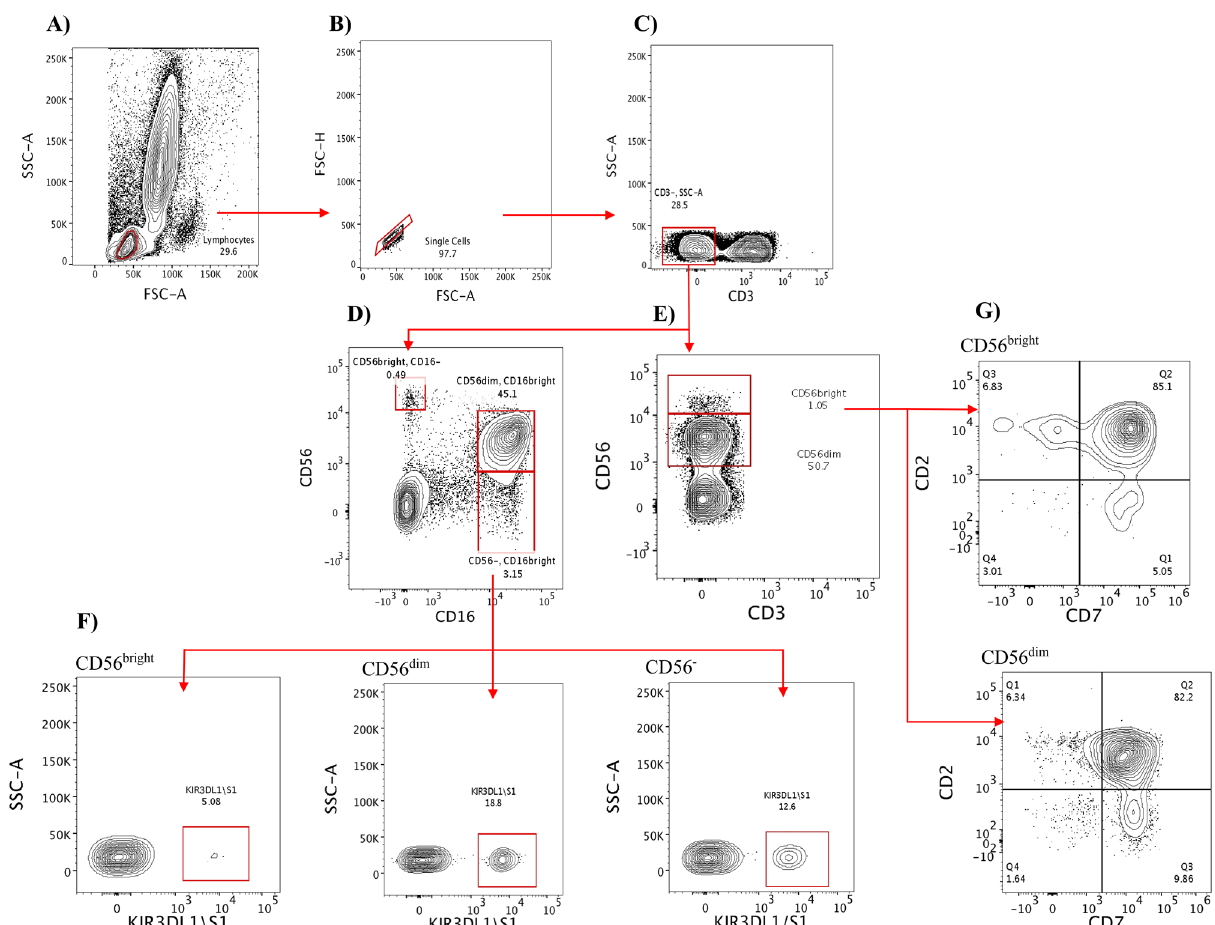
Figure 1. Gating strategy for NK cell subsets. ( A ) The lymphocytes were first identified based on forward (FSC) and side scatter (SSC) analysis; doublets were subsequently excluded with a FSC-H vs FSC-A plot ( B ). ( C ) CD3 − cells were then gated, followed by the definition of the three NK cell subsets in the panels containing CD56 and CD16 ( D ), or two subsets in the panels without CD56 antibody alone ( E ). ( F ) The three subsets (CD56 bright CD16 −ve in the lower-left corner, CD56 dim CD16 bright in the middle, and CD56 −ve CD16 bright in the lower right corner) were further examined for CD8 and KIR3DL1/S1 expression. ( G ) The expression of CD2 and CD7 among CD56 bright CD16 −ve (top right corner) and CD56 dim CD16 bright (lower right corner) is shown . The representative sample for gating illustration was taken from healthy